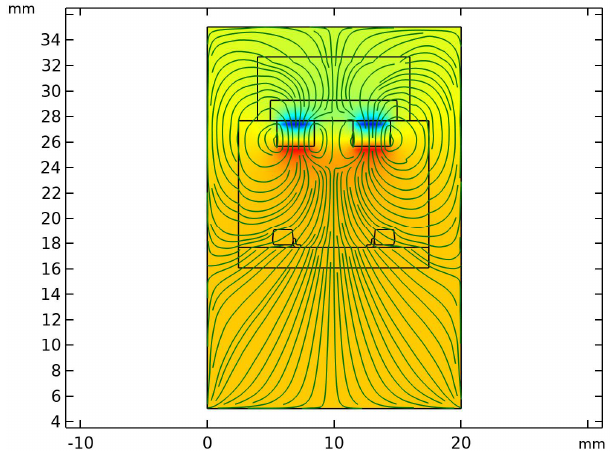
Figure 5. Cross-sectional view of the tactile sensor showing magnetic field lines originating from the magnets.